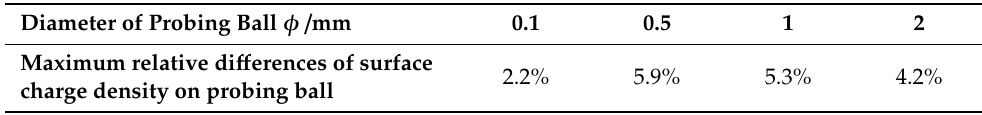
Table 1. Maximum relative differences of surface charge density on the probing point of probing ball between modeling analysis and simulation results ( δ = 0.3 μm).